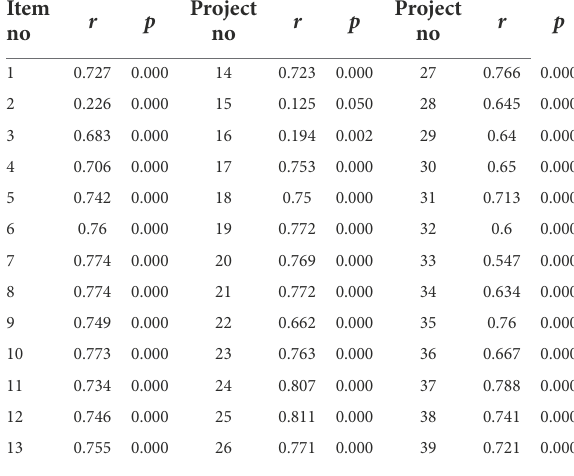
TABLE 2 Analysis of the correlation between the item and the total